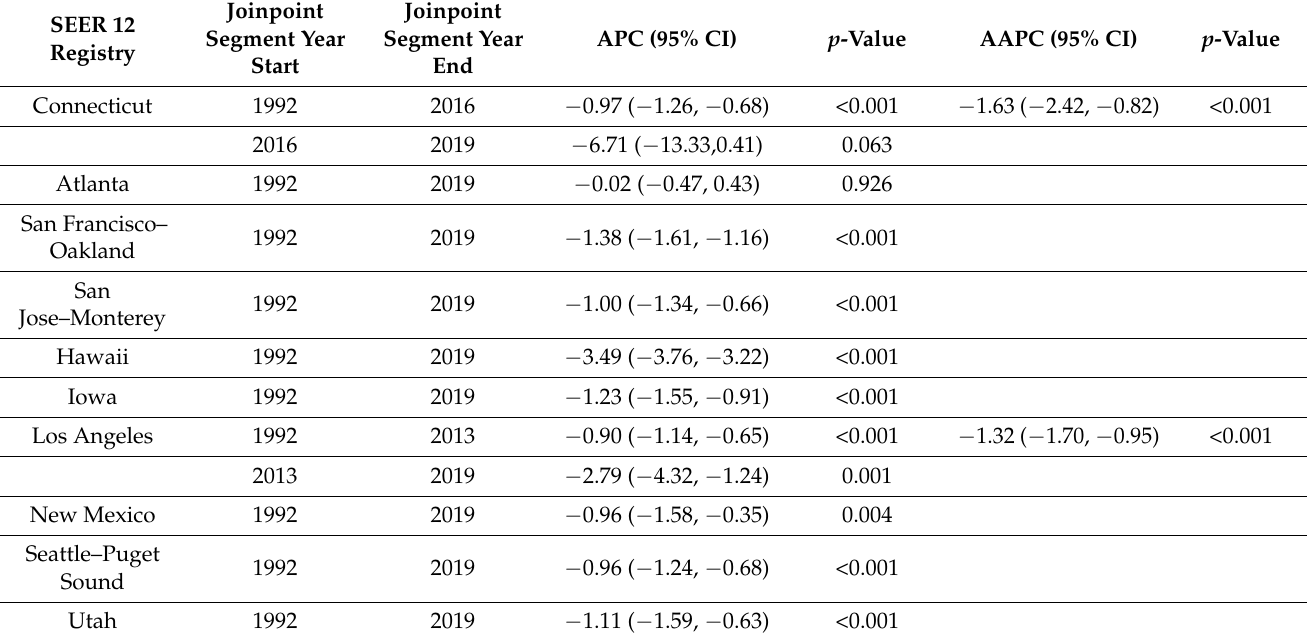
Table 4. Annual percent change (APC) and average annual percent change (AAPC) in EC rates over time by SEER 12